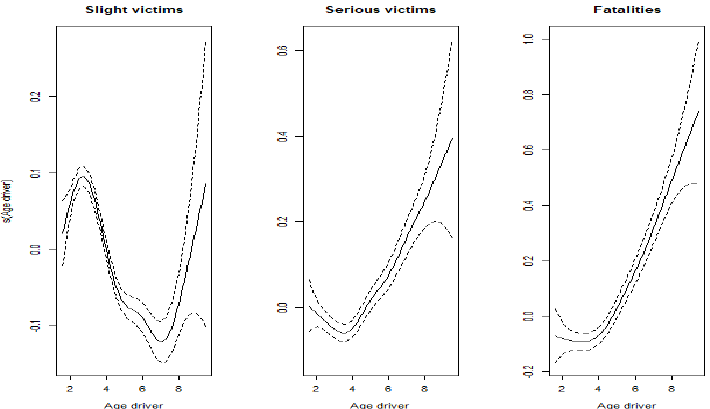
Figure 3. Estimated effect of driver age in the semiparametric binomial GLMM, by BI severity. Different transformations of the two explanatory variables, including polynomials and linear approximations, were analyzed to capture the relationships shown in Figures 2 and